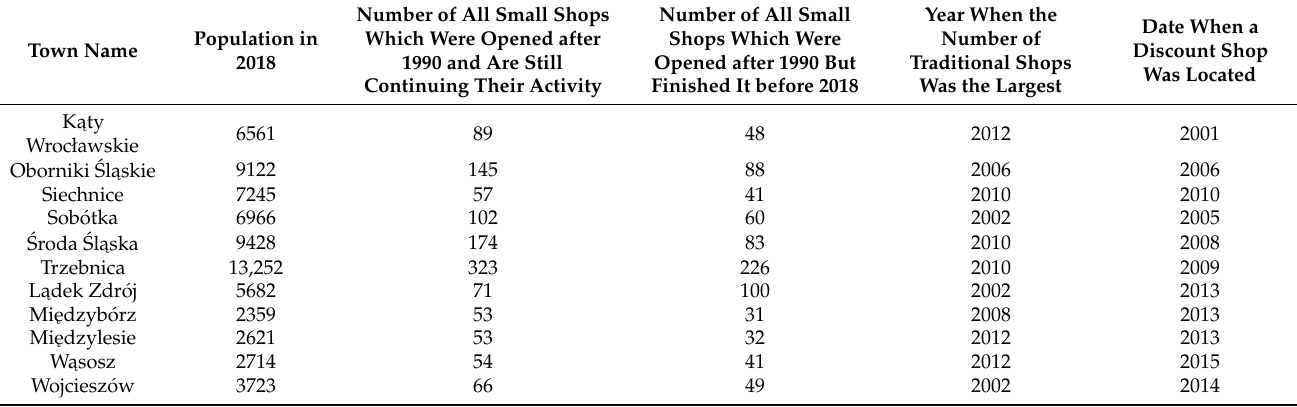
Table 2. The number of traditional shops in small towns. Authors’ own study based on data made available by Statistics Poland Data Applied Computer Science